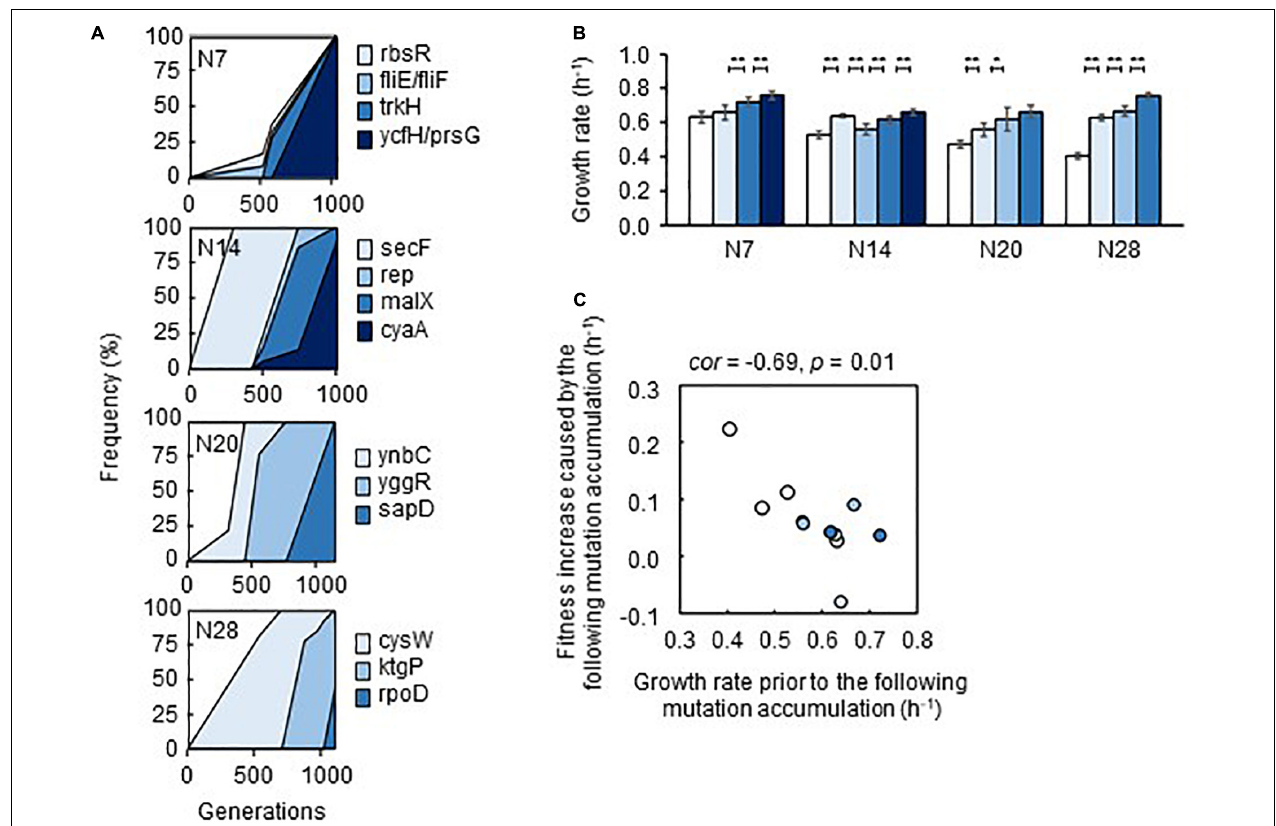
FIGURE 6 | Fitness increase attributed to the mutations. (A) Stepwise accumulation of genome mutations. Mutation during the evolution. The temporal changes in the mutations fixed during the evolution are shown. The four reduced genomes and the gene names of mutants are indicated. (B) Additive increase in the growth rates of the mutants in the medium for evolution. Gradation from white to dark blue indicates the mutants with respect to those shown in (A) . Standard errors of biological replications ( n > 6) are indicated. Asterisks indicate the statistical significance of the two-tailed Student’s t -test (* p < 0.05; ** p < 0.01). (C) Correlation between mutation accumulation and changes in growth rates. A total of 12 mutants of a single accumulated mutation are shown. The Spearman rank correlation coefficients and statistical significance are